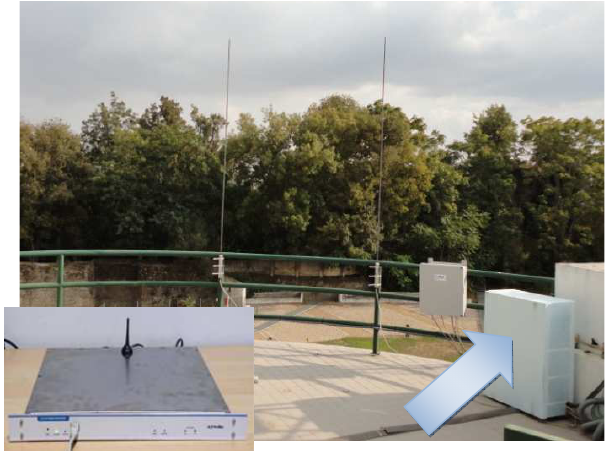
Fig. 3. Photograph of the VLF and LF antennas and the box where receiver is kept (pointed with the blue arrow) at the University of ´Evora. The inset shows the front panel of the receiver.